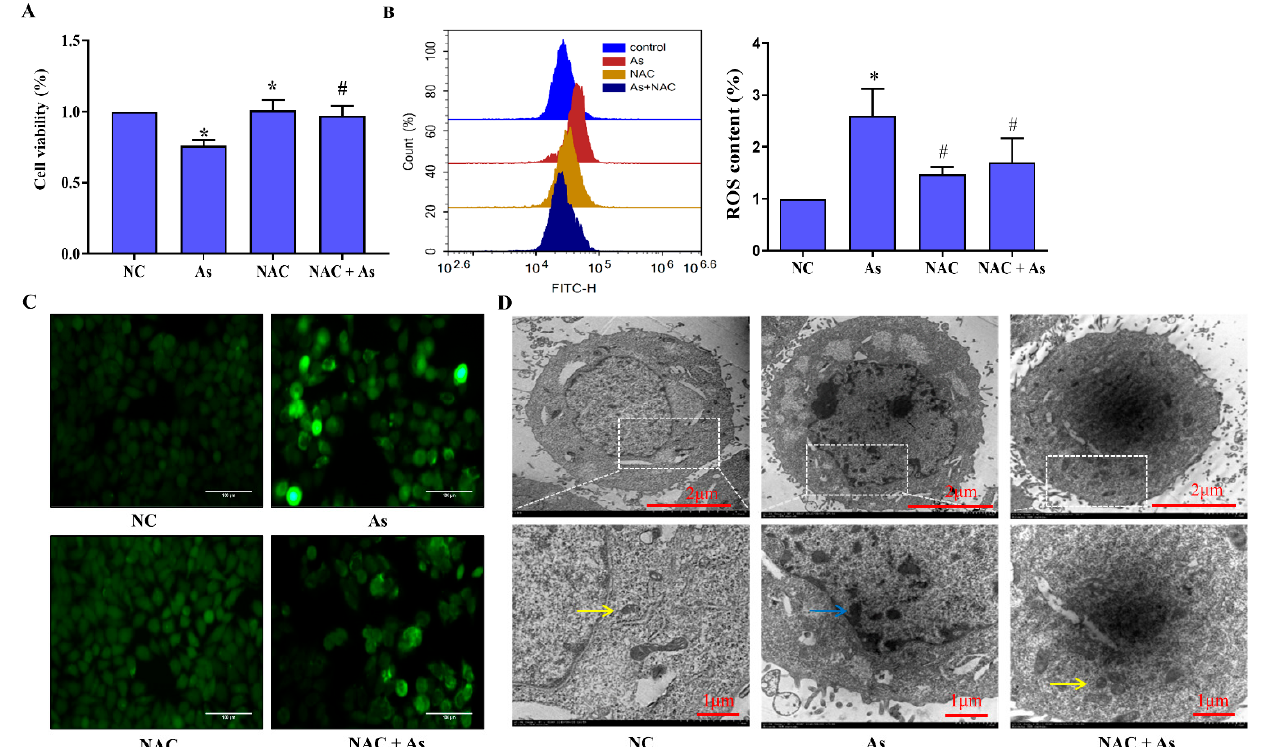
Figure 3. Effects of scavenging ROS on NaAsO2-induced mitochondrial structural damage. ( A ) CCK8 assay was used to detect cell viability of NAC pretreatment. ( B ) Flow cytometry detection of NAC inhibits the accumulation of ROS in L-02 cells induced by NaAsO 2 . ( C ) The ROS detection kit fluorescently detects the effect of NAC on the ROS in L-02 cells induced by NaAsO 2 . Scale bar = 100 µ m. ( D ) Transmission electron microscopy was used to detect the effect of NaAsO 2 on intracellular mitochondria and the effect of NAC. In the figure, the yellow arrow points to normal or slightly damaged mitochondria, and the blue arrow indicates the appearance of mitochondria with disappeared mitochondrial cristae, swelling, and enlargement. * p < 0.05 compared with the control group. # p < 0.05 compared with the As group.